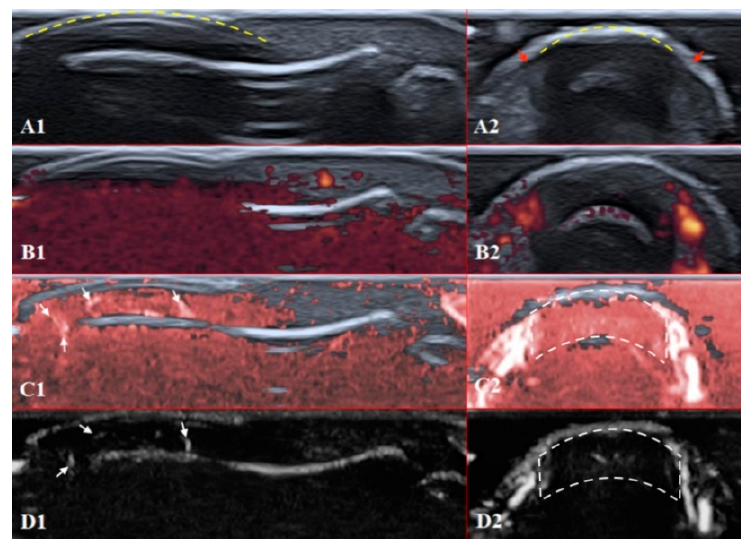
Figure 4. Ultrasound images of the healthy fingertip of the second finger of a hand: ( A1 , A2 ) B mode/grayscale; ( B1 , B2 ) PD; ( C1 , C2 ) cSMI; ( D1 , D2 ) mSMI. The yellow dotted lines mark the nail. Sagittal scans ( B1 – D1 ) in the midline of the fingertip show vascularity from the deep layers of the nailbed to the end of fingertip pulp. The main landmarks for all transverse scans ( B2 – D2 ) are lateral nailfolds ( A2 red arrows), which unite in the middle of the proximal nailfold and become a convex line.